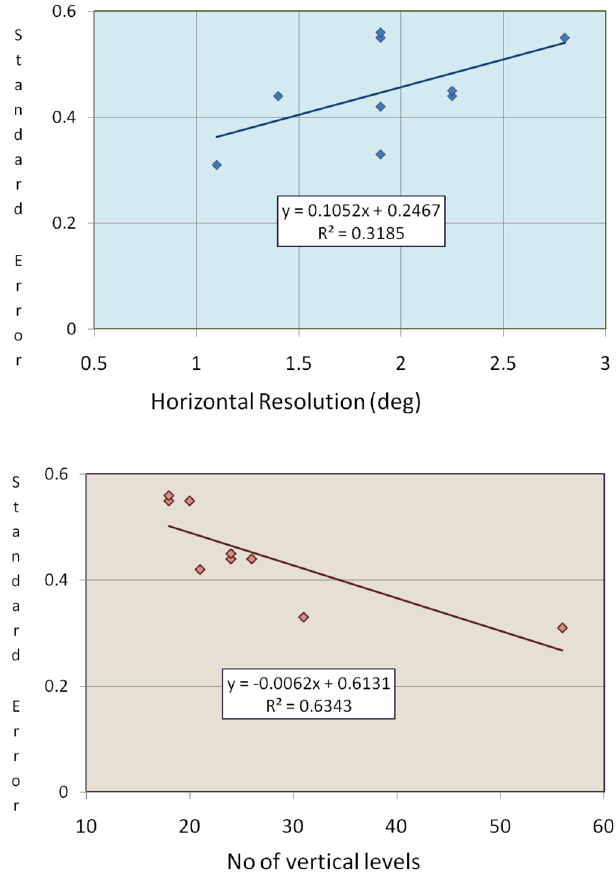
Fig. 11. scatter plots of the standard error (with respect to obser- vation) of the study models in reconstructing the cyclone density distribution and their horizontal (a) and vertical resolution (b)